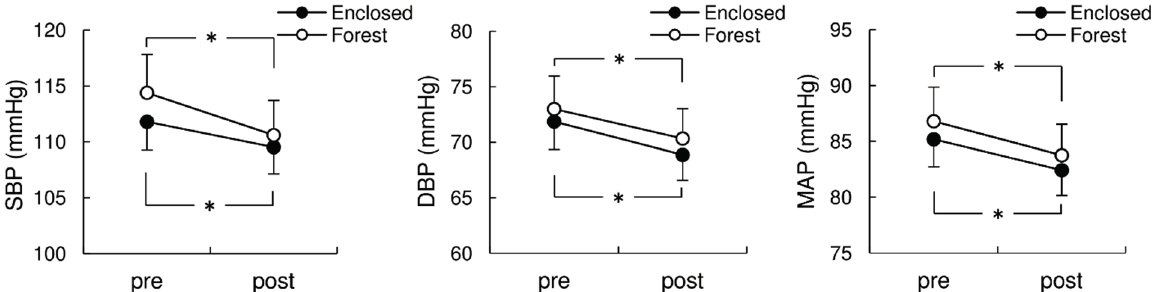
Figure 2. Changes in systolic blood pressure (SBP; left panel), diastolic BP (DBP; middle), and mean arterial pressure (MAP; right) between the Forest and Enclosed conditions. Values are mean ± SEM ( n = 15). * p < 0.05 between pre- and post-values within each condition with the Bonferroni post-hoc